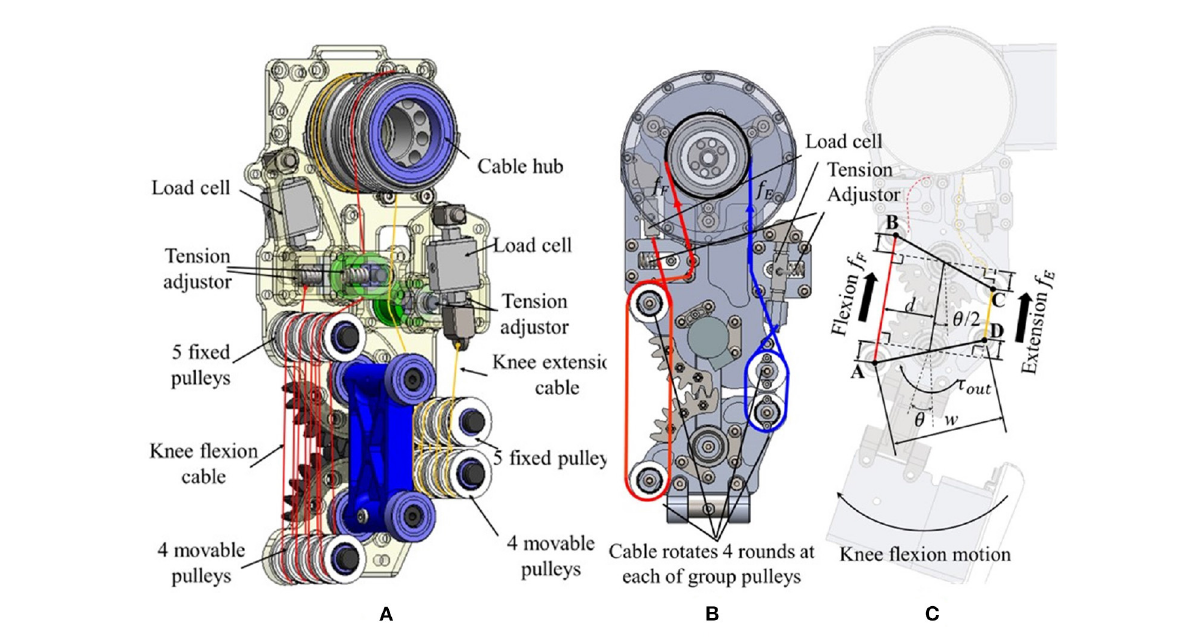
FIGURE4 The detailed structure of the knee exoskeleton. (A) The flexion cable (red line) and extension cable (yellow line) is driven by a cable hub and pass through fixed (upper) and movable (lower) pulleys used to realize the tension-amplification mechanism. (B) Cable routing, force sensing, and tension adjuster. (C) Relationship between the cable motion and joint angle. High stiffness cable-tension amplification mechanism. The tension-amplification mechanism realizes the function of the speed reduction mechanism with a gear ratio of 8 and the resultant stiffness is 64 times the stiffness of the cable, see Equation